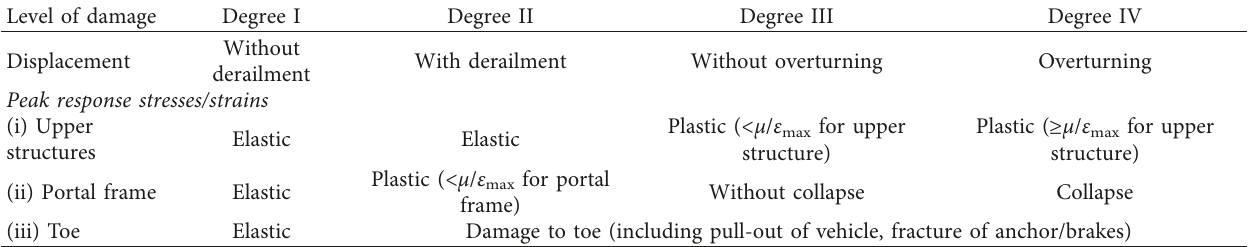
Table 5: Damage criteria for cranes according to PIANC [30].